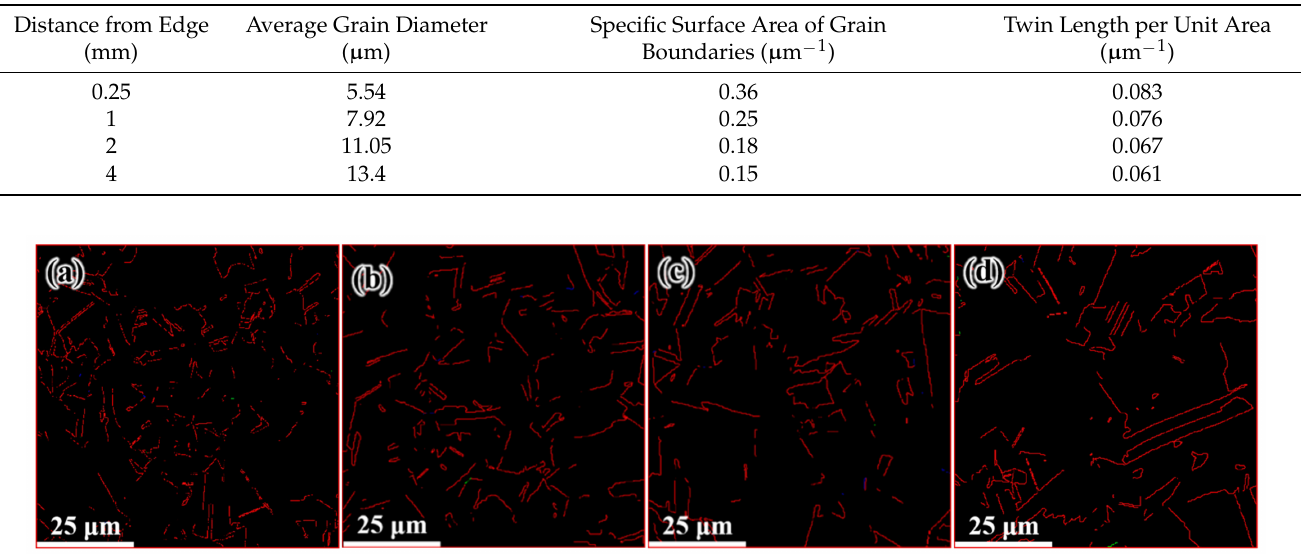
Figure 7. Distributions of twin boundary after CE at 150 ◦ C: ( a ) 250 µ m from edge, ( b ) 1 mm from edge, ( c ) 2 mm from edge, and ( d ) 4 mm from